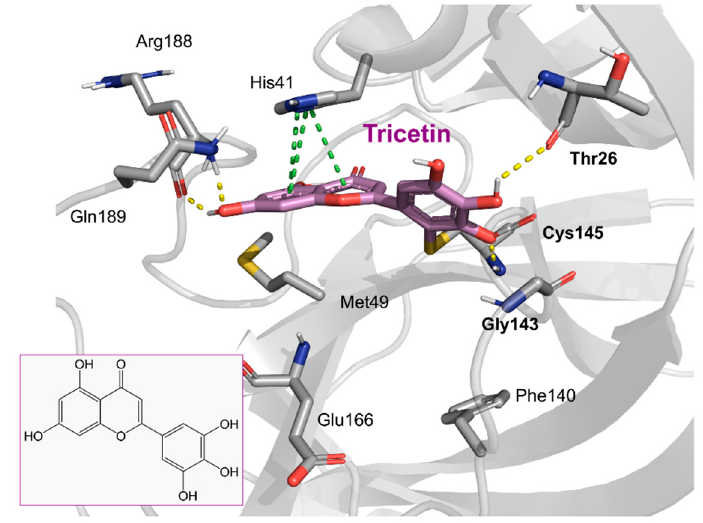
Figure 3. The putative tricetin binding mode in the M pro binding site. Dashes represent different interaction types: green— π -stacking, yellow—polar contacts such as hydrogen bonds.